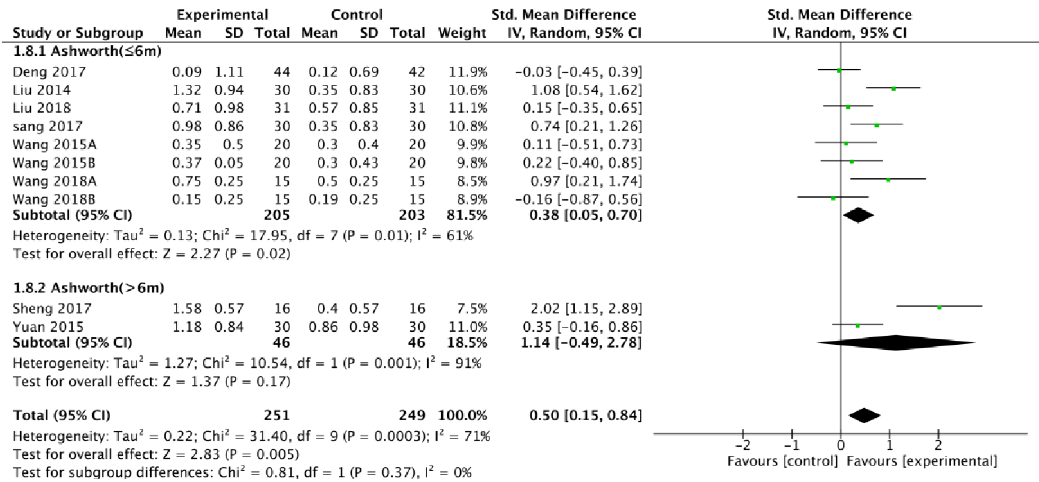
Fig 9. Meta-analysis of fire acupuncture versus acupuncture for spasticity after stoke according to the course of disease.